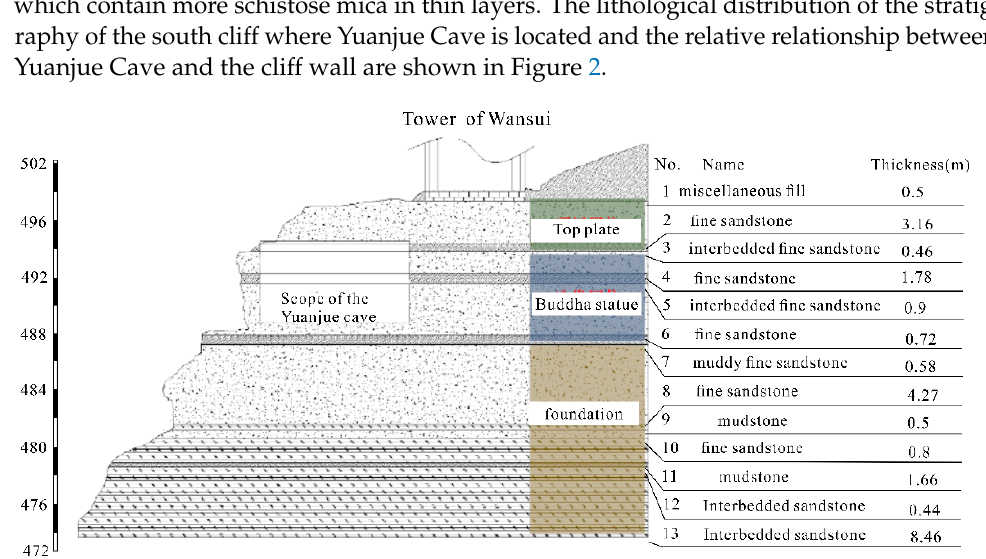
Figure 2. Detailed geological strati fi cation of the south cli ff wall on which Yuanjue Cave is located